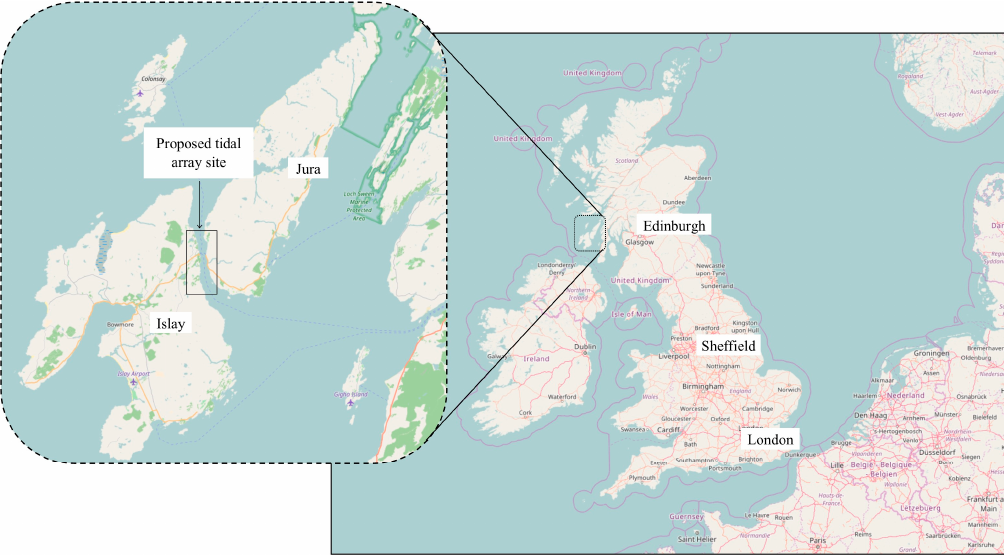
Figure 3. Location of ScottishPower Renewables, Sound of Islay site (Map data © OpenStreetMap contributors, CC BY-SA).